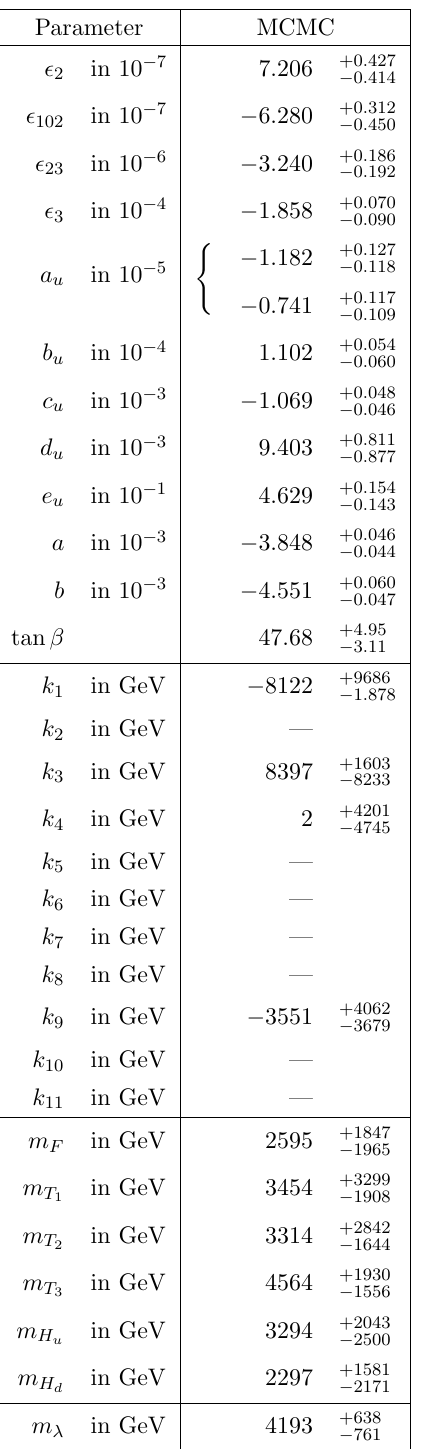
Table 1 . The 1 (cid:27) HPD intervals combined with the mode values of the parameters of the MCMC analysis. The \|" indicates that the parameter is uniformly distributed within the prior. The moduli of all k i are restricted to values smaller than 10 TeV. The two values of a u correspond to the two solutions of the (leading order) equation y u (cid:25) j ( Y u ) 11 (cid:0) ( Y u ) 2